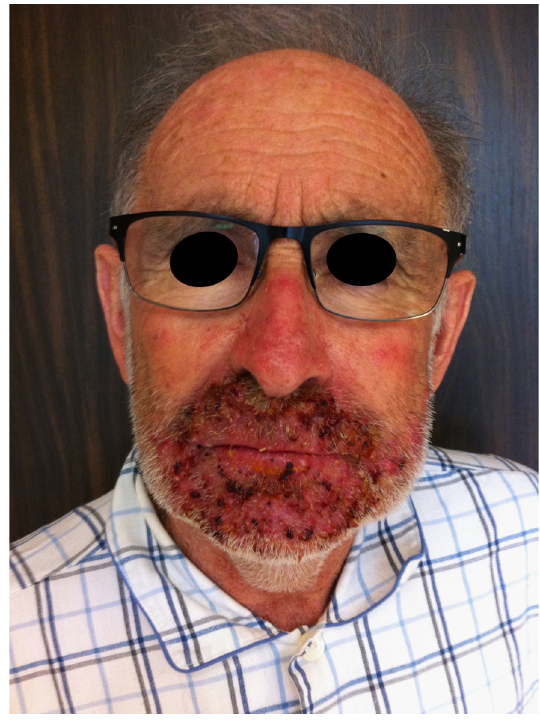
Fig. 1. Papulopustular lesions of the face caused by panitumumab: front view of the